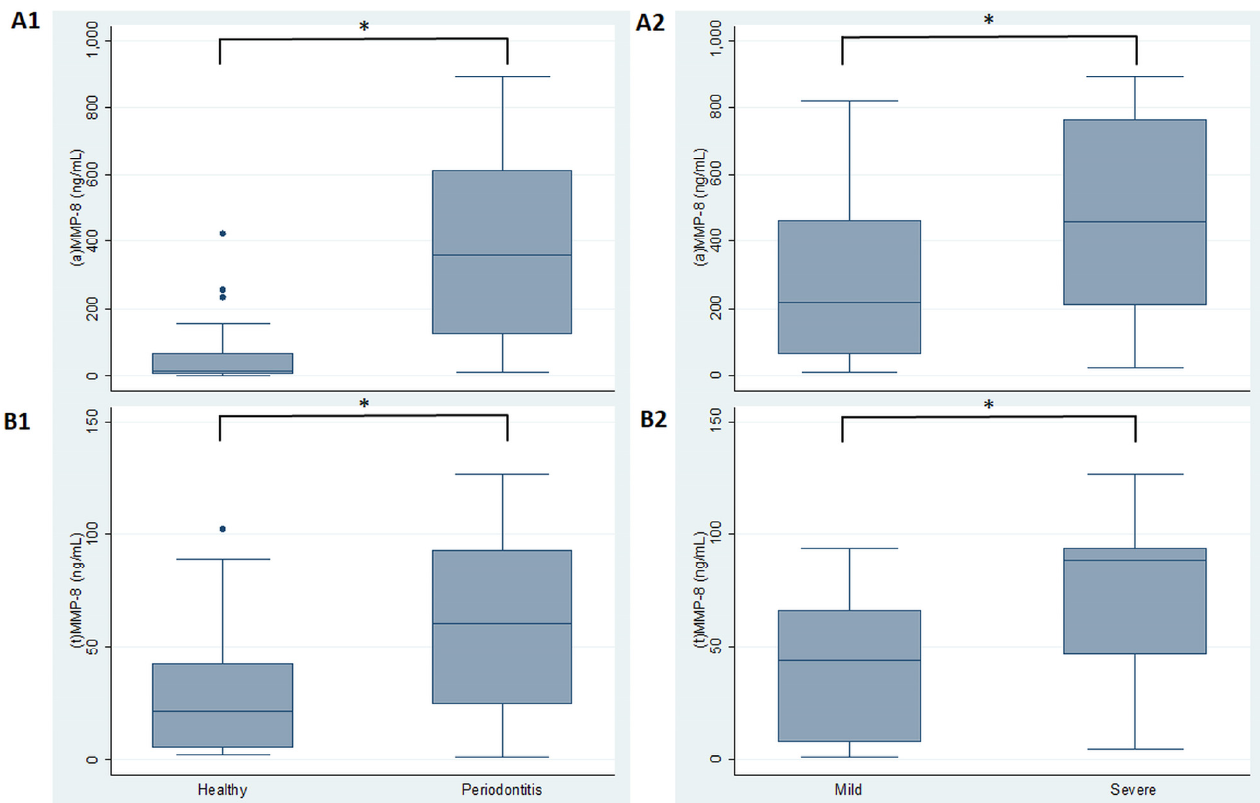
Figure 1. MMP-8 levels in healthy and periodontitis sites. ( A1 ) Active and ( A2 ) total MMP-8 levels by diagnosis. ( B1 ) Active and ( B2 ) total MMP-8 levels by disease periodontitis severity. (a) active; (t) total. * p < 0.0001.